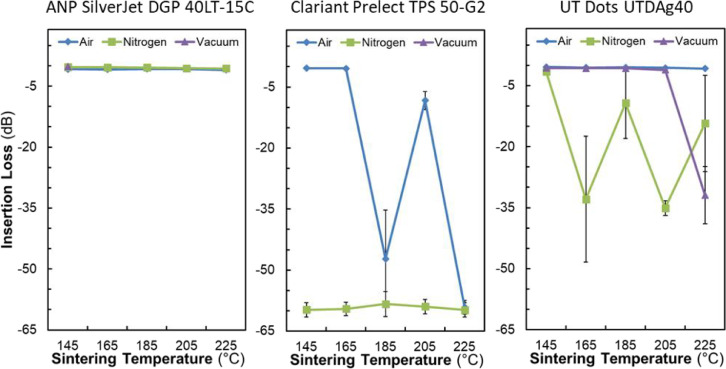
A subset of the insertion loss data (mean ± SD, n=5) is shown wherein insertion losses are averaged over the x-band range (7 GHz – 11.2 GHz) and plotted as a function of sintering temperature.